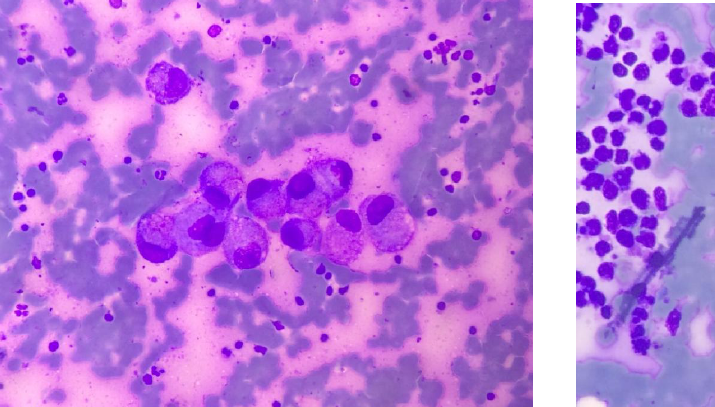
Fig 3: Smear showing malignant cluster of metastatic adenocarcinoma with signet ring component.